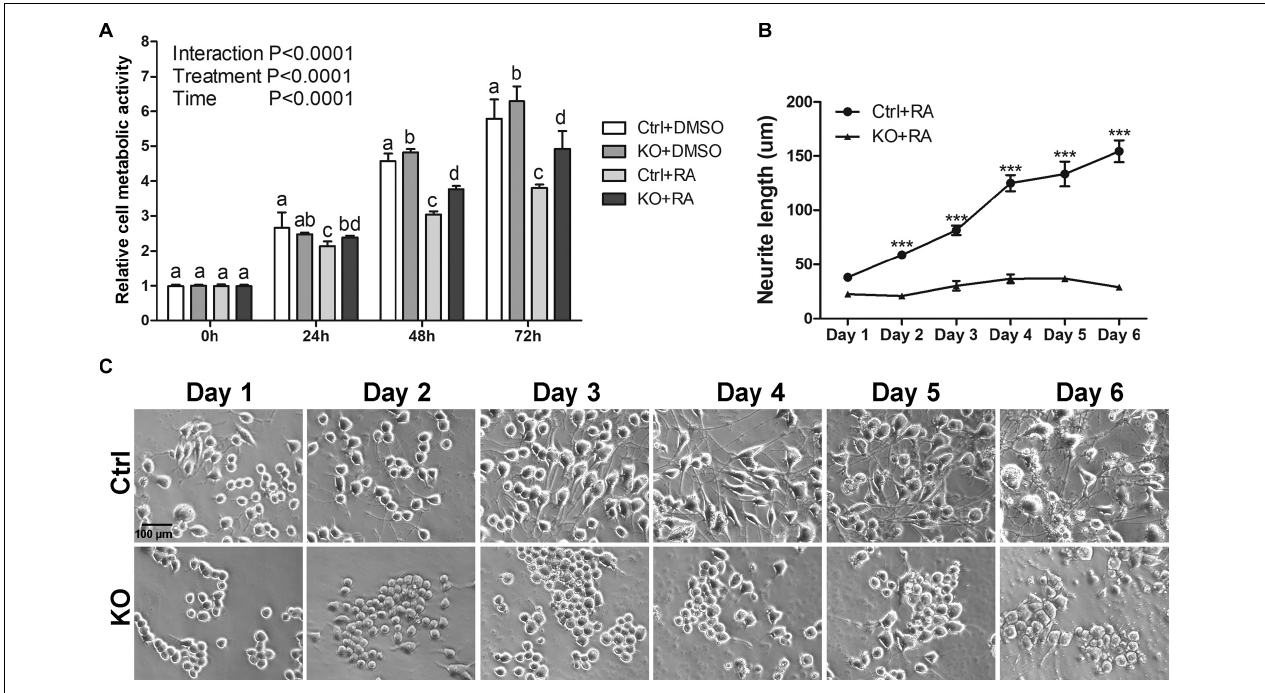
FIGURE 2 | The reduction of neurite outgrowth in MANF KO cells is neither due to toxicity nor delayed process. (A) Cell metabolic activity at 0, 24, 48, and 72 h of RA treatment was tested by MTT assay. Different letters above columns indicate significant differences between treatments as tested by two-way ANOVA followed with the Bonferroni’s post hoc test ( P < 0.05). The data were expressed as the mean ± SEM of three independent experiments. (B) Average neurite length of control and MANF KO cells after 6 days of RA treatment was determined and analyzed by Two-way ANOVA followed with the Bonferroni’s post hoc test, *** P < 0.001. The data were expressed as the mean ± SEM of three independent experiments. (C) Representative images of control and MANF KO cells treated with